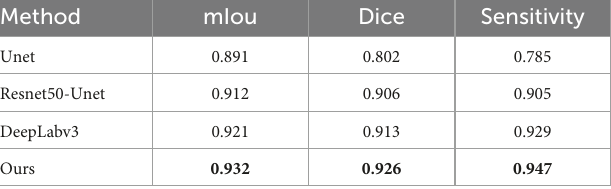
TABLE 2 mIOU, dice coefficient, and sensitivity for CCPR region segmentation by different methods. Method